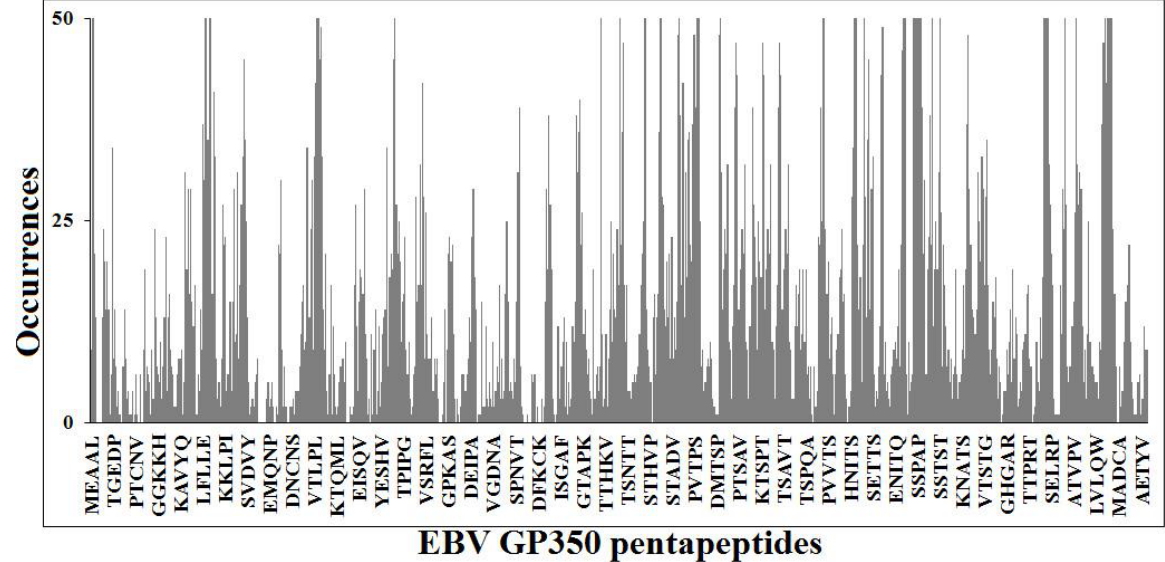
Figure A1. Pentapeptide identity platform shared between EBV GP350 protein and the human proteome. Peptide aa sequences in one letter